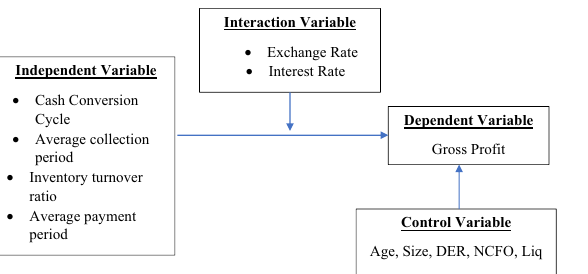
Fig. 1 Conceptual model of the study. This fi gure explores the graphical fl ow of the study. The CCC, ACP, ITR, and APP are used as the independent variables while the exchange rate and the interest rate are used to check the macroeconomic factor moderating role on fi rms fi nancial performance, i.e., gross pro fi t. We also used some control variables Age, Size, DER, NCFO, Liq.